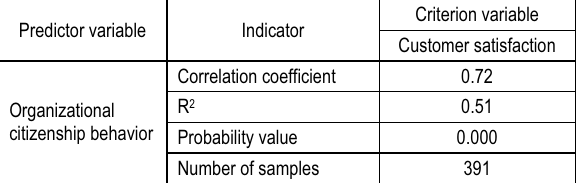
Table 4. The relationship between organizational